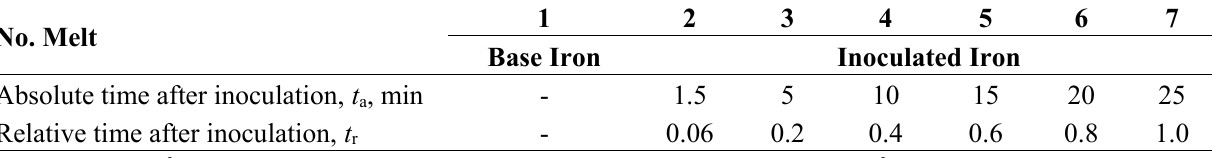
Table 9. Absolute and relative times after inoculation in cast iron and their effects on N F